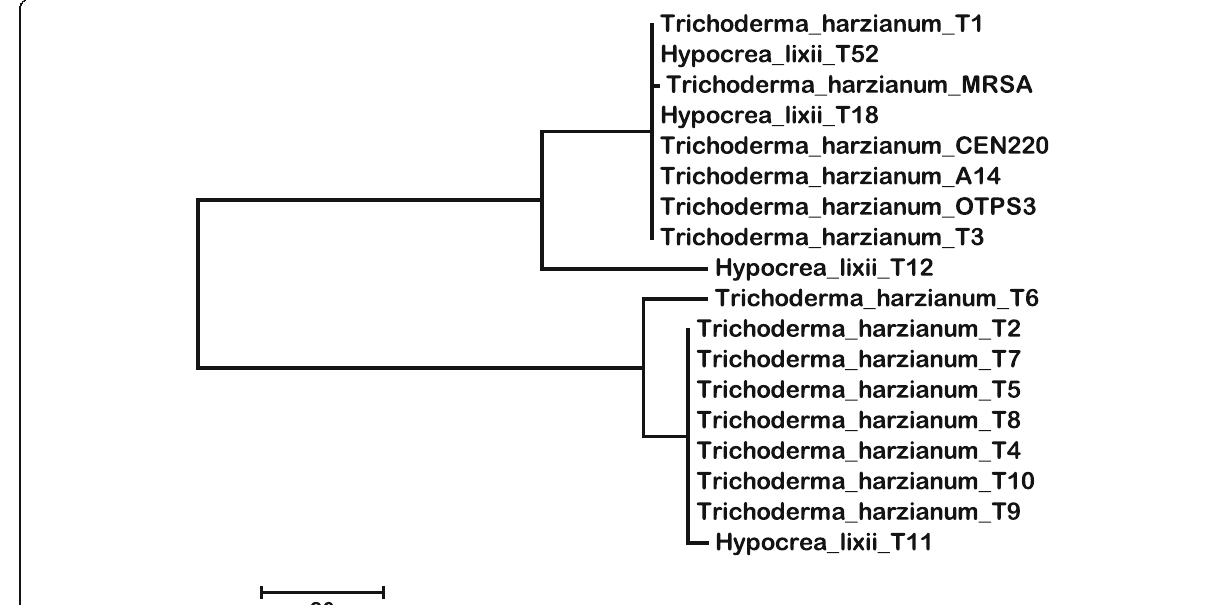
Fig. 1 Phylogenetic tree and diversity of the 5.8S-ITS region in 12 Trichoderma sp. isolates compared with reference Trichoderma strains. The phylogenetic tree was generated using parsimony neighbor-joining and maximum likelihood